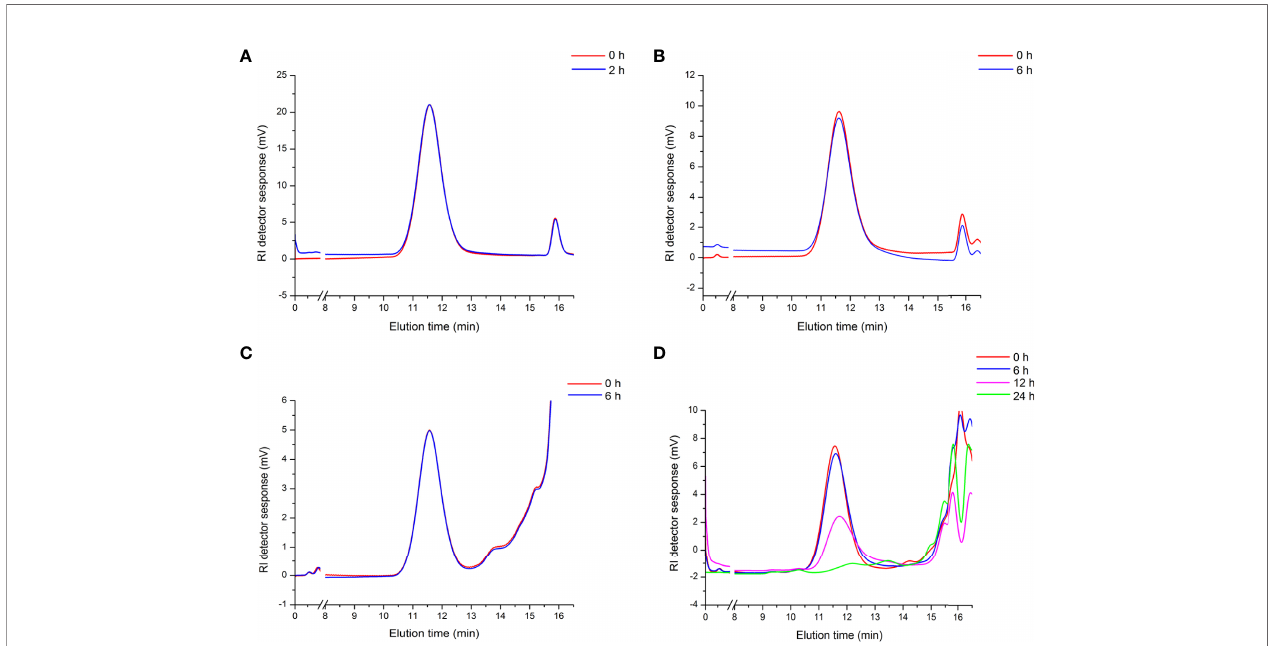
FIGURE 4 | Arti fi cial gastrointestinal digestions and fermentation of APEP-A-b. Molecular weight distributions of the APEP-A-b during saliva (A) , gastric (B) , small intestinal digestions (C) and fermentation (D) in different processing times in vitro .